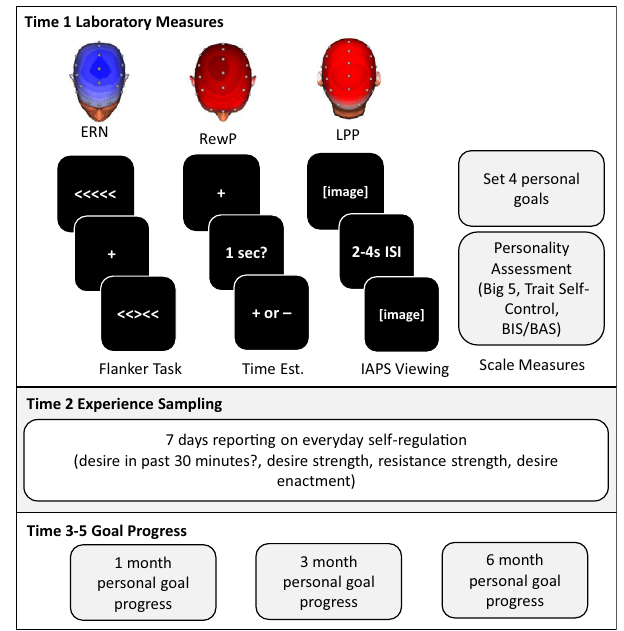
Fig. 1 Schematic overview of our longitudinal mixed-methods design. The laboratory measures were assessed at intake (top panel), the subsequent week-long experience sampling at time two (middle panel), and the three follow-ups on personal goal progress at time-points 3 – 5, corresponding to 1-, 3-, and 6-month follow-ups, respectively. ERN: error-related negativity; RewP: reward positivity; LPP: late positive potential; ISI: inter-stimulus interval; BIS: Behavioral Inhibition System; BAS: Behavioral Activation System; IAPS: International Affective Picture